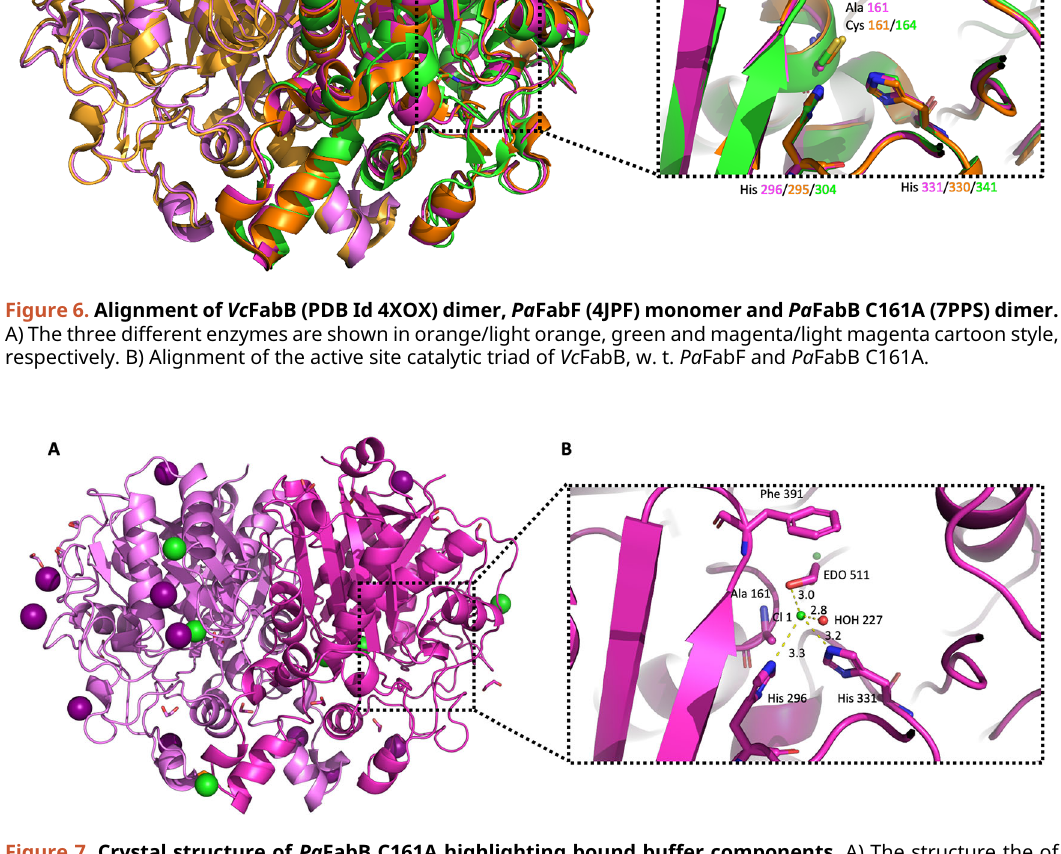
Figure 7. Crystal structure of Pa FabB C161A highlighting bound buffer components. A) The structure the of Pa FabB C161A homodimer is shown in carton style coloured in magenta/light magenta. Iodine and chloride ions are shown with deep purple and green colour, respectively. B) Active site residues are shown as magenta sticks, water molecules and chloride ions are shown as red and green spheres, respectively, while the distances between the chloride ion Cl1 and the neighbouring molecules are shown as yellow dashed